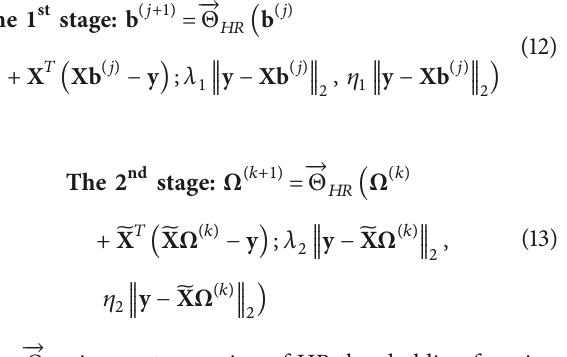
Algorithm 1 exhibits the details of TSRHR algorithm